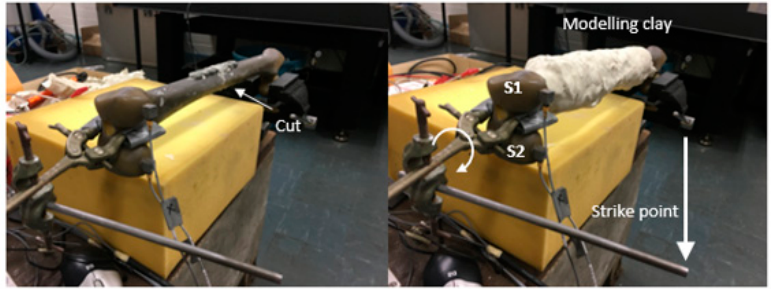
Figure 3. Experiment test setup indicating saw blade cut, modelling clay, two accelerometers and strike point.